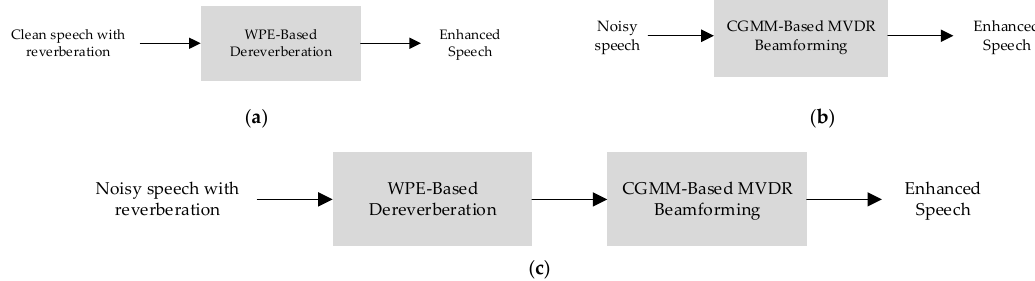
Figure 13. The block diagram of the multi-channel speech enhancement method: ( a ) Weighted prediction error (WPE)-based dereverberation method; ( b ) complex Gaussian mixture model-based minimum variance distortionless response (CGMM-MVDR)-based denoising method; ( c ) WPE-CGMM-MVDR-based dereverberation and denoising